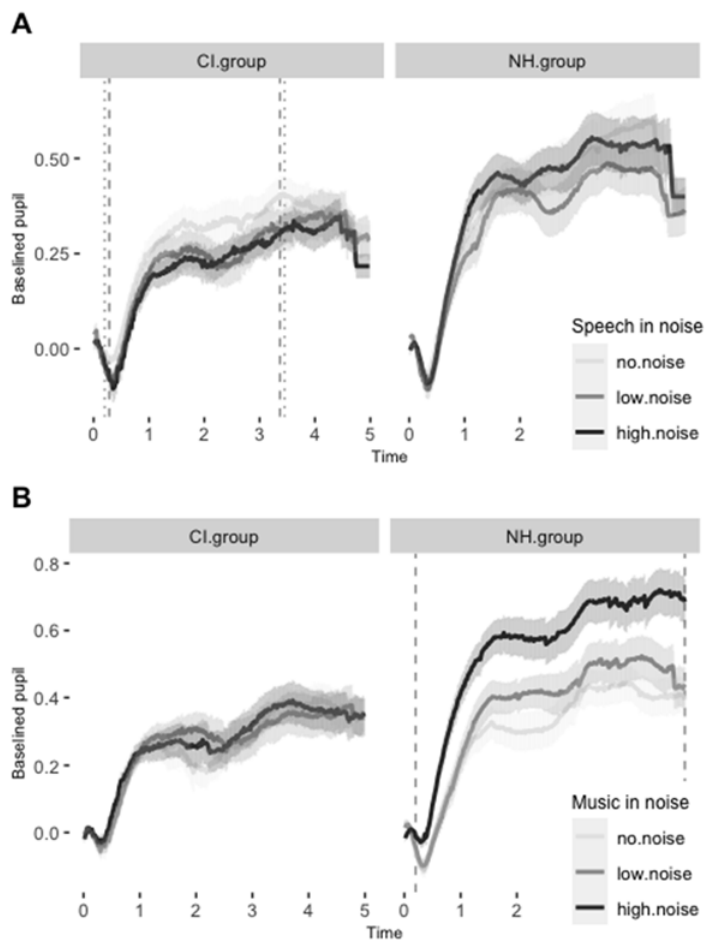
Figure 3. ( A ) The averaged time course of the pupillary responses to speech in various noise conditions in both groups. The dashed vertical lines represent the (cluster-based) estimate of the time-window of marginally significant differences between No and High noise conditions. The dotted vertical lines represent the time-window of marginally significant differences between No and Low noise conditions. ( B ) The averaged time course of the pupillary responses to music in various noise conditions in both groups. The dashed vertical lines represent the (cluster-based) estimate of the time-window of significant differences between No and High noise conditions.